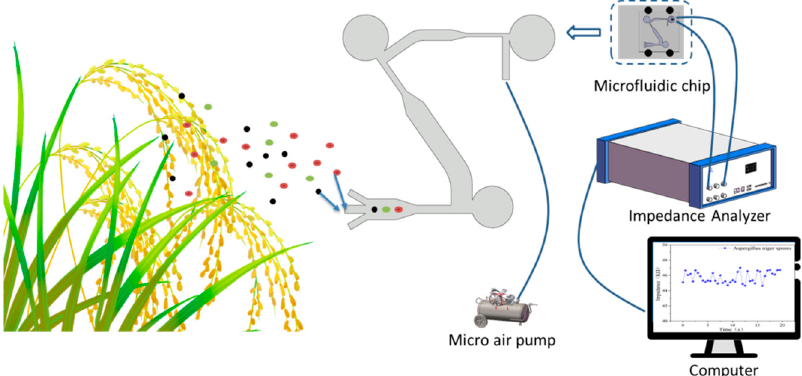
Figure 1. Schematic diagram of the working principle of the detection